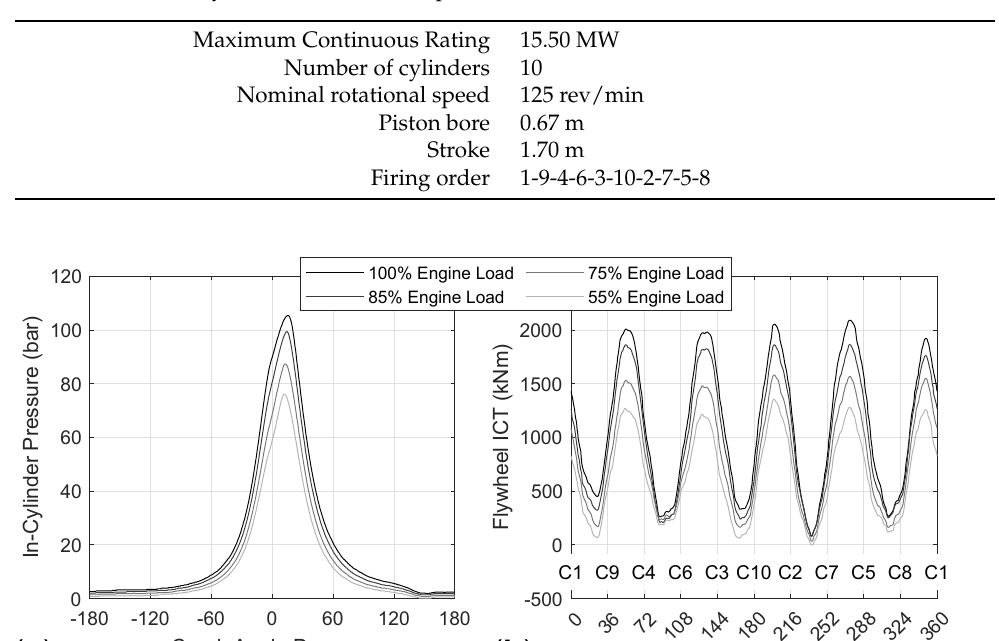
Table 1. Reference system basic technical specifications [18].